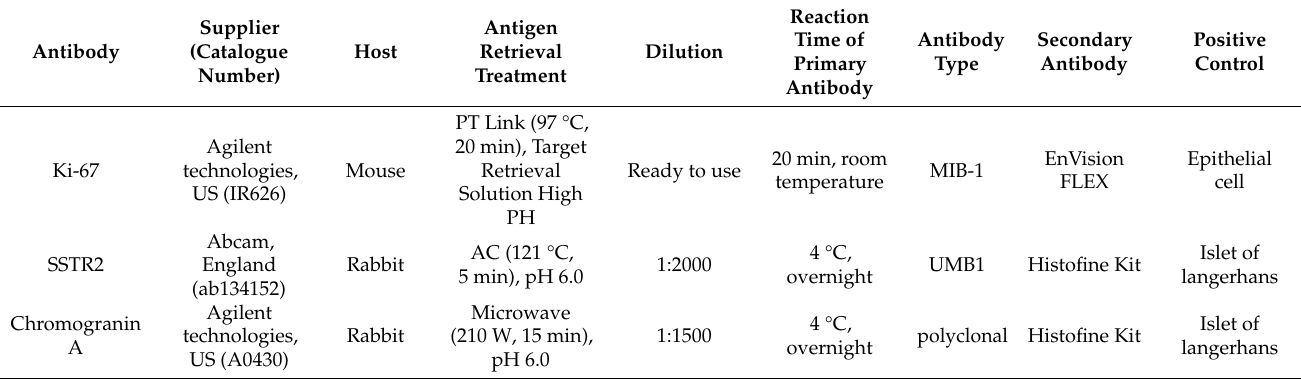
Table 1. Summary of the protocols of immunohistochemistry used in this